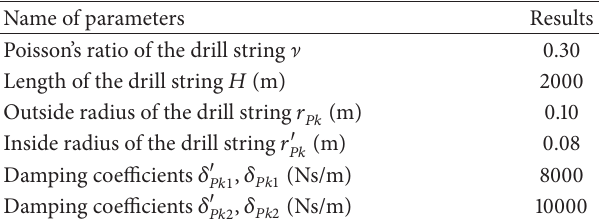
Figure 4: Influence of inside radius on dynamic stiffness. Table 4: Calculation parameters of the damping coefficient influ- ence.